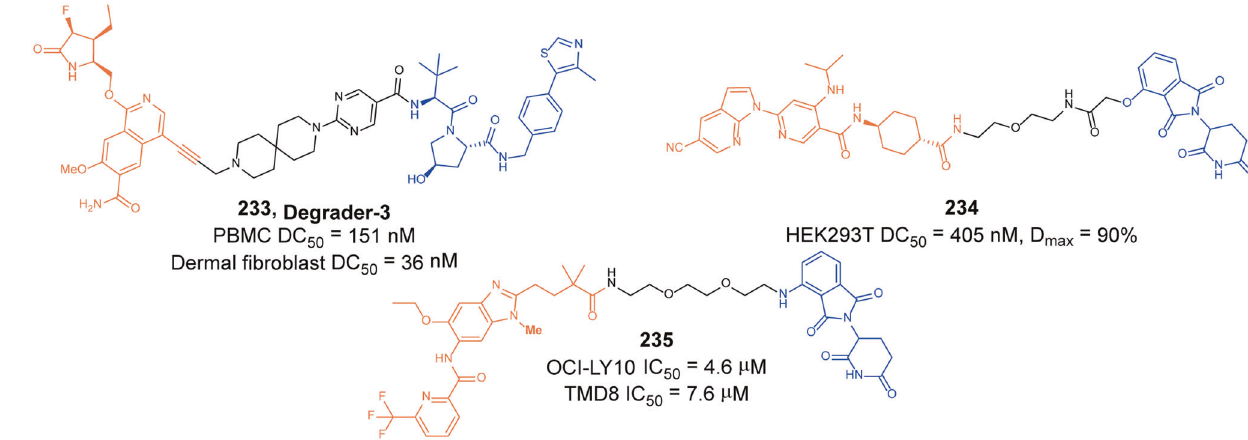
Fig. 79 The representative PROTACs targeting IRAK4